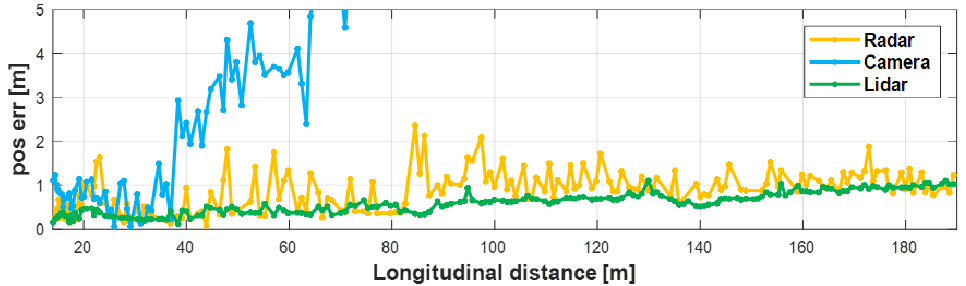
Figure 14. Position error when not using the proposed